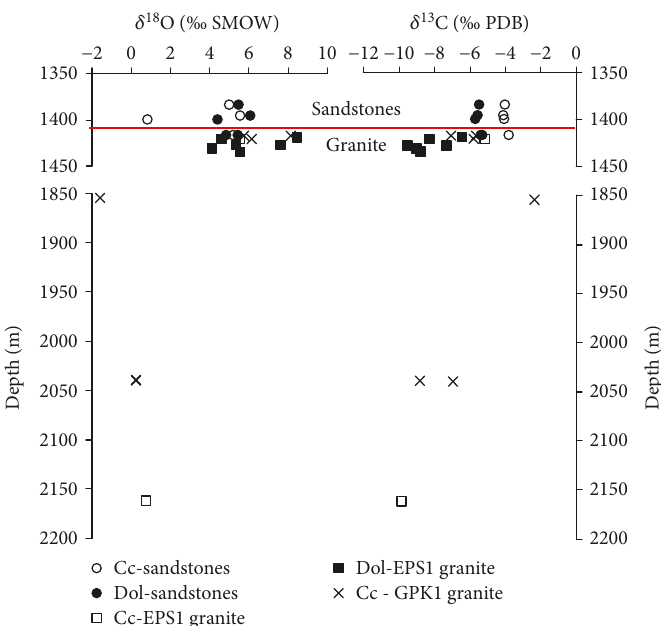
δ 13 C Figure 13: Pro fi les of δ 18 O fl uid and fl uid reported as a function of depth. The dolomite in the upper part of the granite and the sandstones from the EPS1